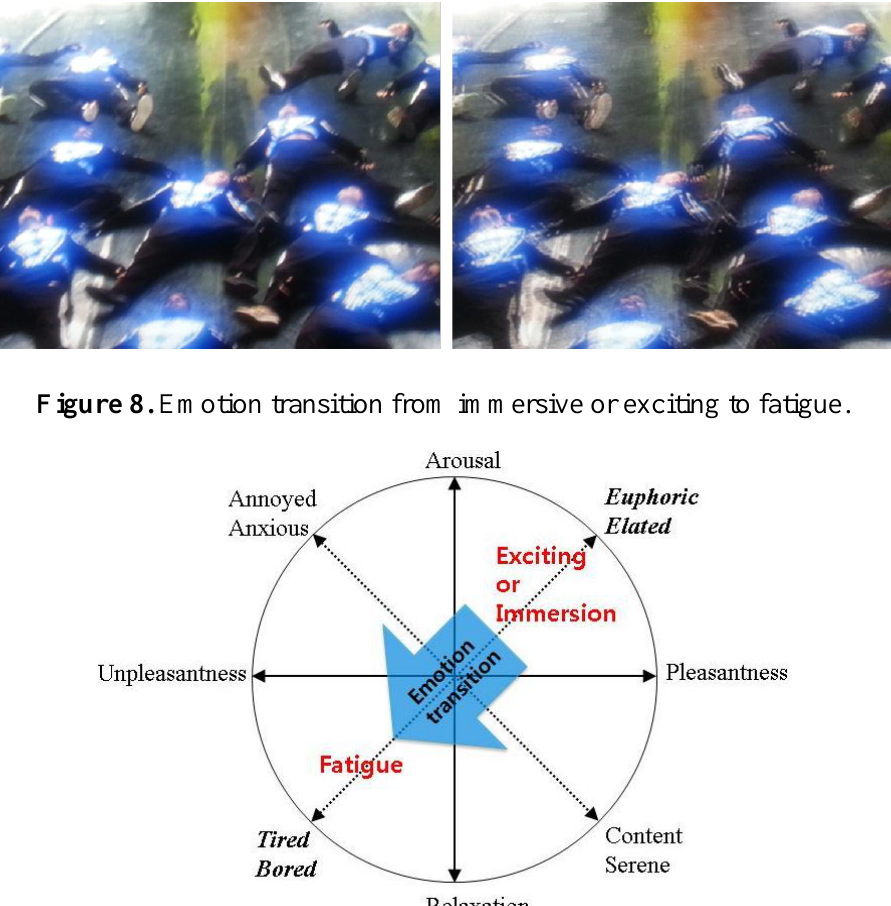
Figure 7. Still image examples for 2D ( left ) and 3D ( right ) displays.